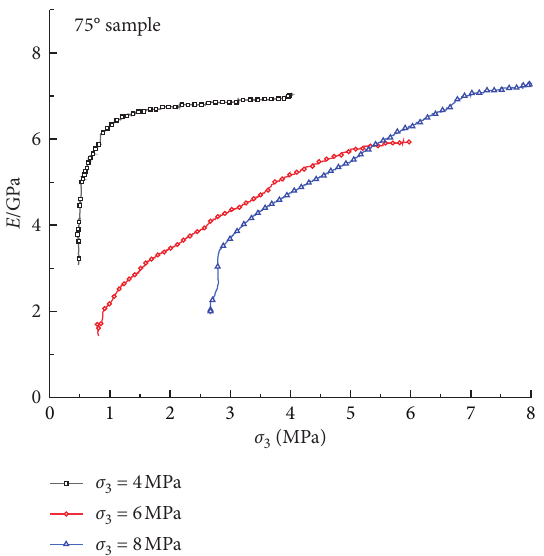
Figure 5: Relation curves of deformation modulus and confining pressure.